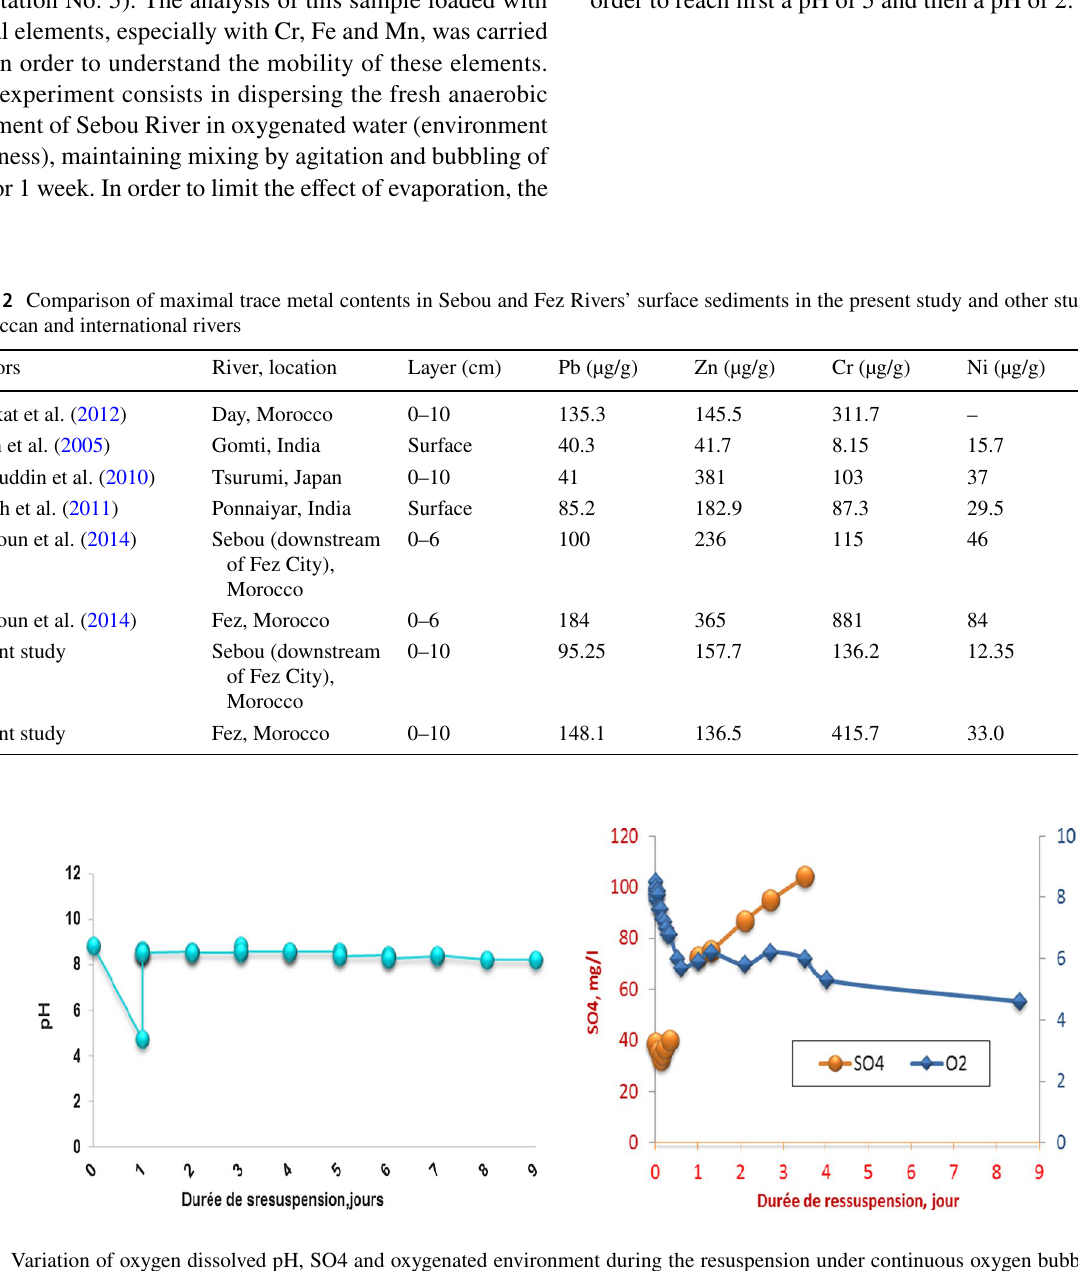
Fig. 2 Variation of oxygen dissolved pH, SO4 and oxygenated environment during the resuspension under continuous oxygen bubbling of fresh sediment of Sebou